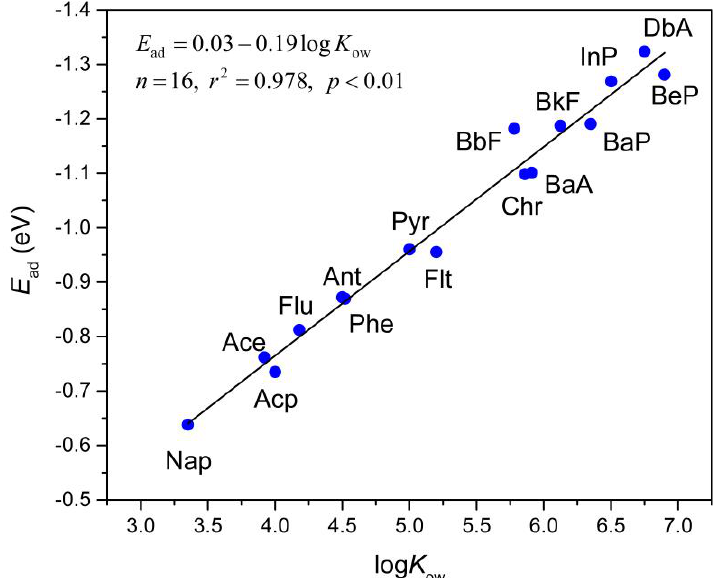
Figure 4. The correlation between the adsorption energy ( E ad , in eV) and logarithm of the octanol/water partition coefficient (log K ow ) of selected PAHs molecules. The straight line is fitted to Equation (3) which is shown in the inset.